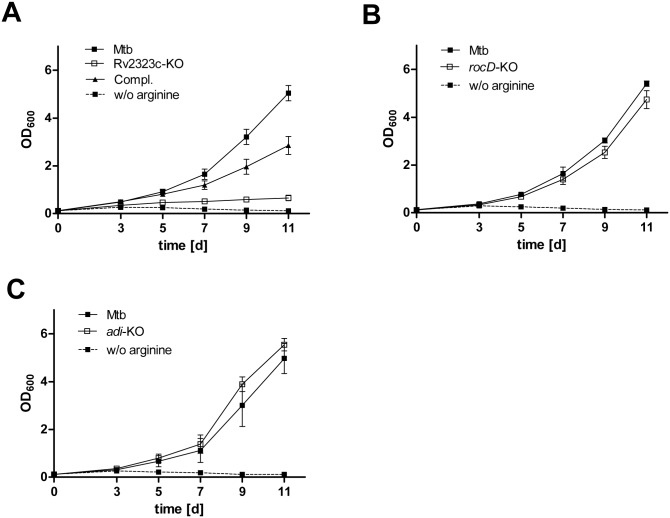
Growth of Mtb knockout strains lacking Rv2323c, rocD, or adi on arginine as nitrogen source.Mtb wild type (Mtb), Mtb knockout mutants of Rv2323c (Rv2323c-KO) (A), rocD (rocD-KO) (B), adi (adi-KO) (C), and the complemented strain for the Rv2323c knockout mutant (Compl.) (A) are shown. All strains were cultured for 11 days in minimal medium with glycerol and glucose as carbon sources, and with 5 mM of arginine as a sole nitrogen source (solid line). Mtb wild type was also cultured without arginine as a control (broken line). Growth was analyzed measuring absorbance (OD600) at day 3, 5, 7, 9, and 11. Mean values and standard deviations are shown for three independent biological experiments.